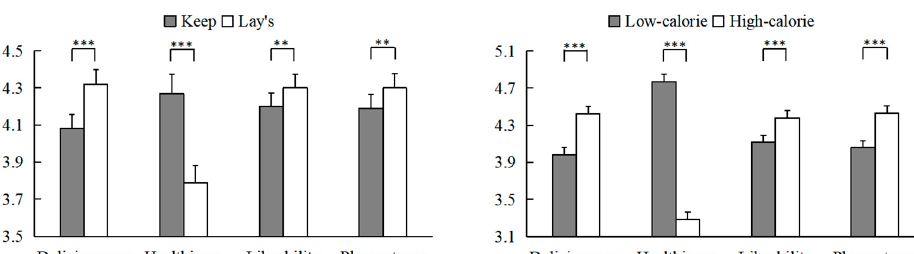
Figure 2. The main effects of brand type and food calories on subjective ratings and purchase inten- tion in Study 1. Error bars show the standard errors of the means. ** denotes p < 0.01 and *** denotes p < 0.001. Figure 1. The mean scores of subjective ratings and purchase intention in Study 1. Error bars show the standard errors of the means. Table 1. The results of ANOVAs conducted on the data collected in Study 1.